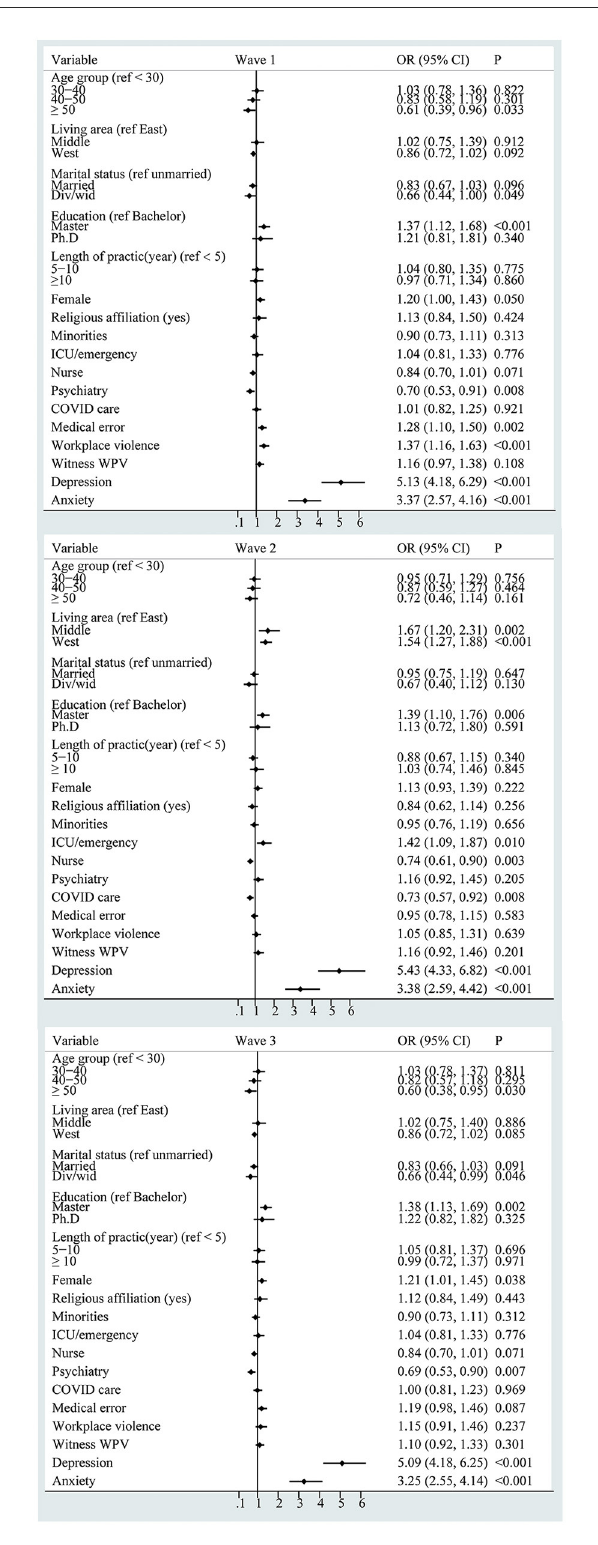
FIGURE2 Forest plot of the correlators of emotional exhaustion (WPV: workplace